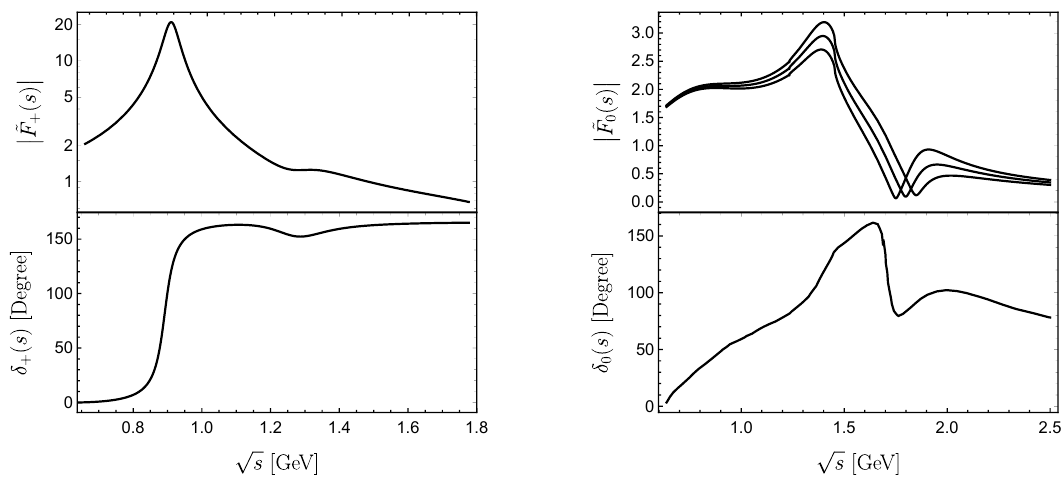
Figure 3 . Moduli and phases of the K(cid:25) vector (left) and scalar (right) form factors. The vector form factor is taken from refs. [50, 51], while the scalar form factor is from refs. [53, 60], with the ranges of the modulus obtained by varying the form factor at the Callan-Treiman point